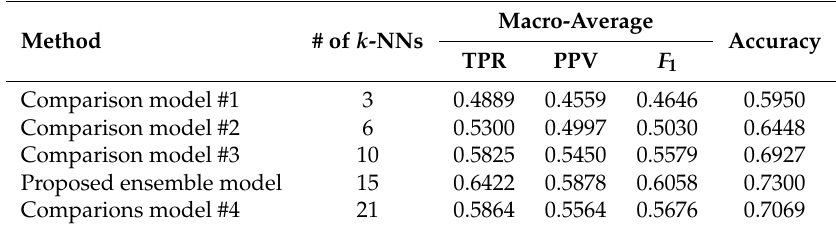
Table 13. Leave-one-person-out cross-validation performance comparisons between ensemble models with different numbers of k -NN classifiers.